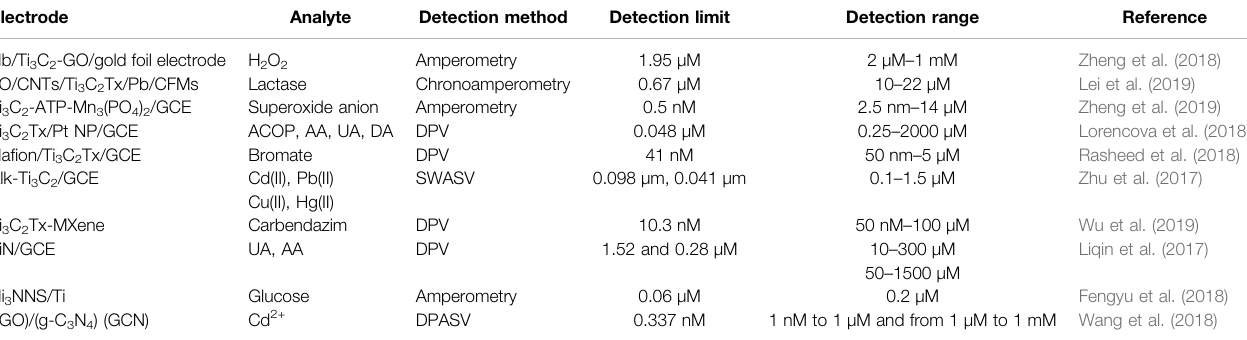
TABLE 4 | Metal carbide, Metal Nitride based electrochemical sensors for detection of various species.